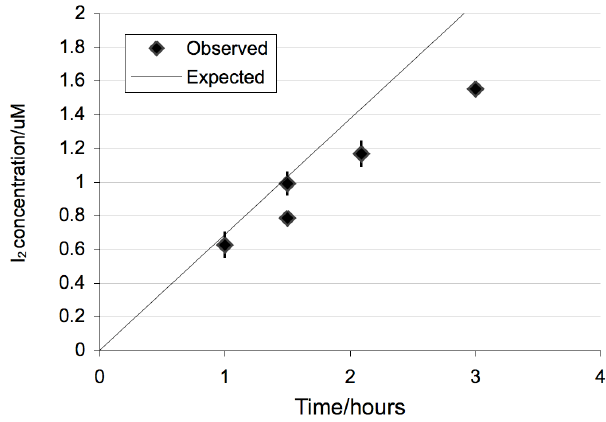
Fig. 4. Observed and expected iodine concentrations in prototype hexane solvent trap at − 9 ◦ C. Error bars show ± 1 standard devia- tion where sufficient replicates were